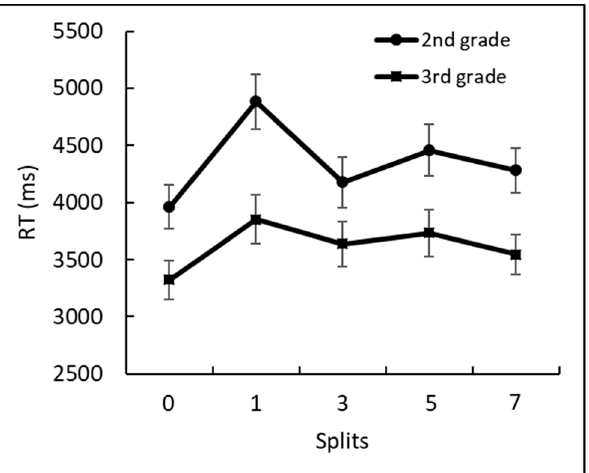
Figure 12. The reaction times for each split (i.e., deviation level from the correct value) by grade.